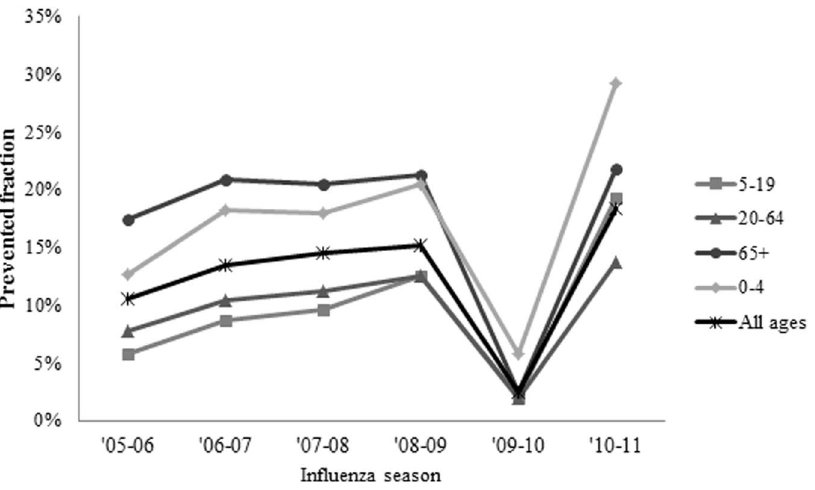
Figure 1. Prevented fraction of influenza cases, by age group, 2005/06–2010/11 influenza seasons.